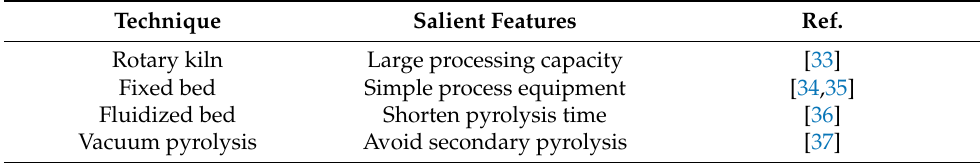
Table 1. A tabular summarized data on pyrolysis. Technique Salient